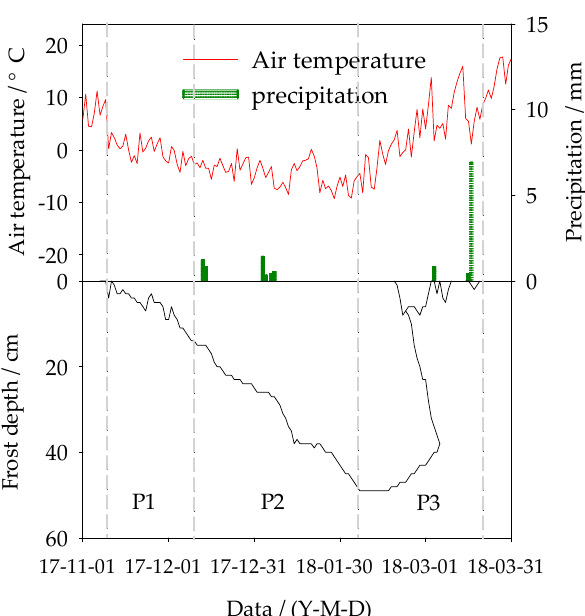
Figure 3. Soil freezing and thawing process from November 2017 to March 2018.